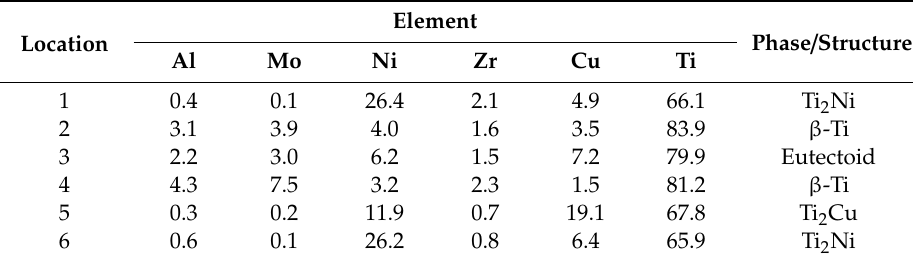
Figure 6. BSE-SEM micrographs of cross-sectional view of the B3 sample: ( a ) the center of the brazed zone, ( b ) the edge of the brazed zone as displayed in Figure 2. Table 1. Chemical compositions in at% of marked sites in Figure 6.